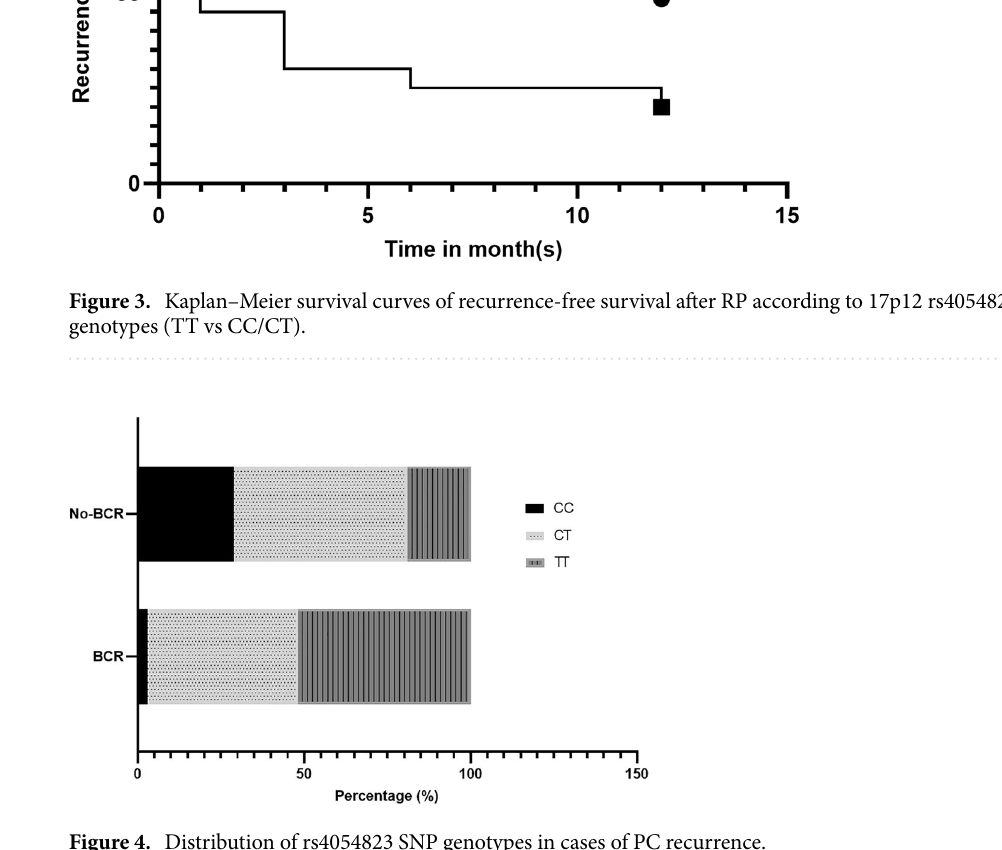
Figure 4. Distribution of rs4054823 SNP genotypes in cases of PC